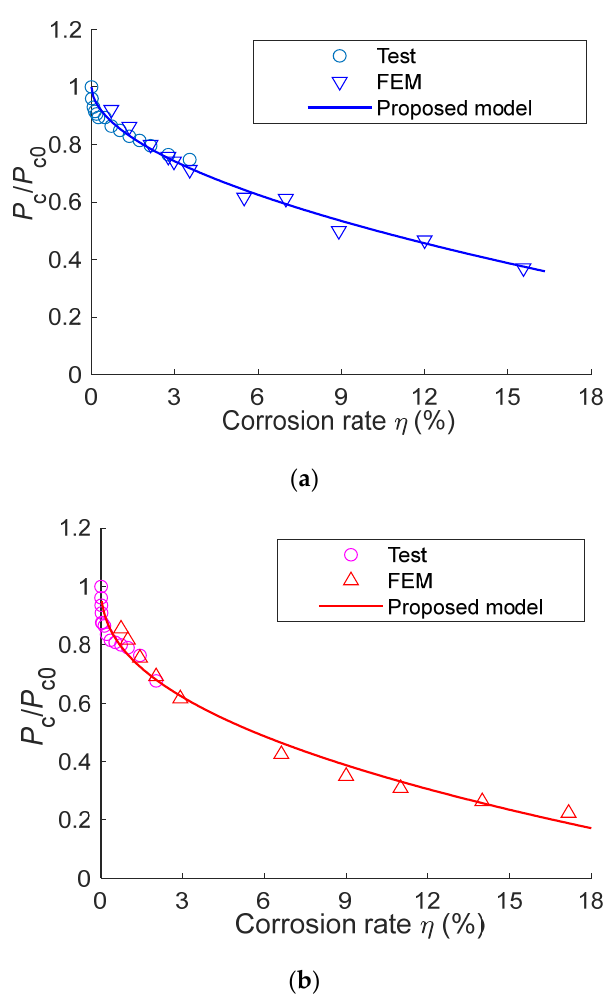
Figure 19. Proposed model for the PF-HSB after corrosion. ( a ) TX Series; ( b ) TY Series.